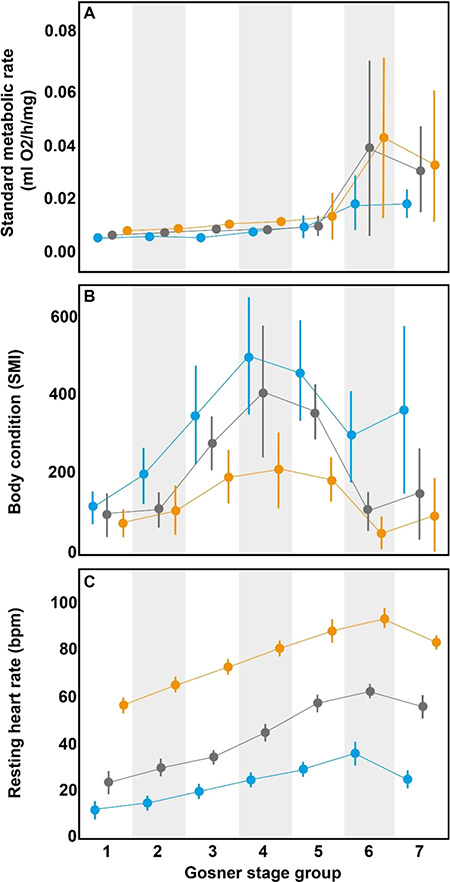
Effects of altered TH levels due to endocrine disruption and ontogenetic stage on mean ± SD A standard metabolic rate (mg O2/mg/h), B body condition measured as scaled mass index (SMI), and C resting heart rate (beats per minute) during the development of the common frog (Rana temporaria). Blue dots = low TH levels (i.e. SP treatment). Grey dots = Control group. Orange dots = high TH levels (i.e. T4 treatment).